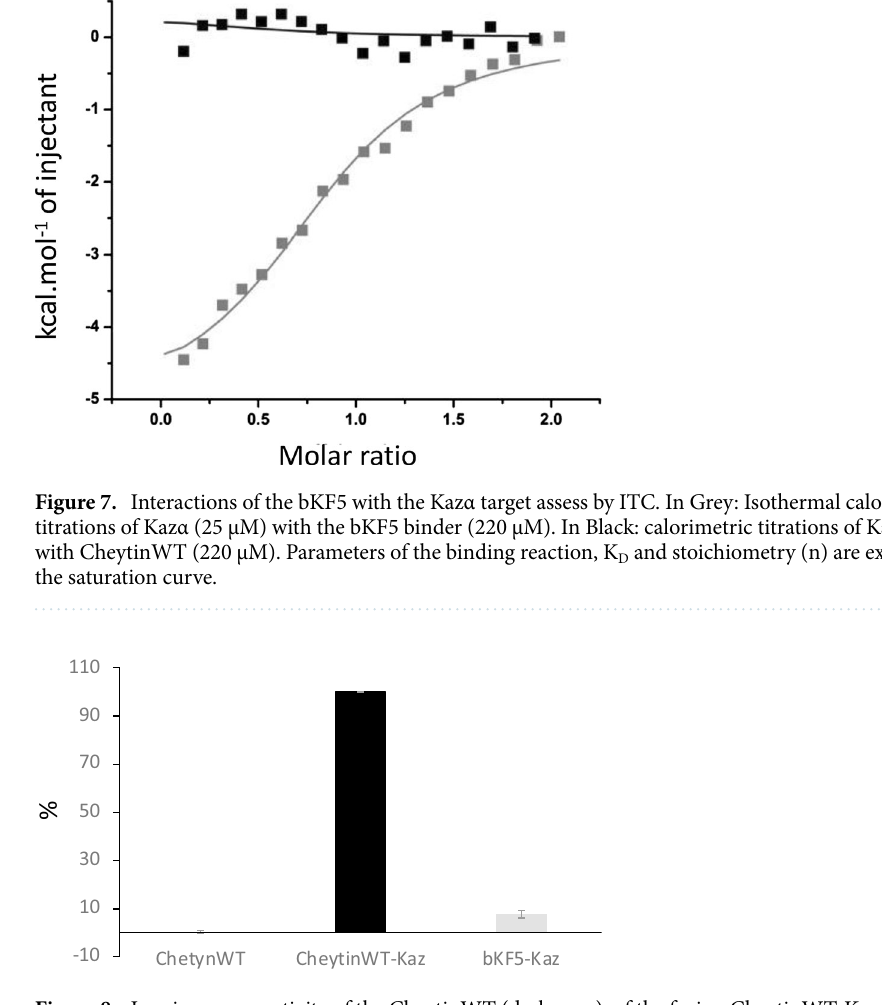
Figure 8. Luminescence activity of the CheytinWT (dark-grey), of the fusion CheytinWT-Kazα (black), and the bKF5-Kazα (low-grey) after addition of the Nano-Glo substrate. For each experiment, the maximal luminescence activity obtained with the CheytinWT-Kazα has been defined as the 100% activity and all other values (CheytinWT, and bKF5-Kazα) have been normalized accordingly. For each protein sample, 3 independent experiments were performed. For each experiment, the average of triplicate measures is calculated. Each measure corresponds to the average of 20 records of the Kaz activity luminescence signal monitored during 1 min in initial rate